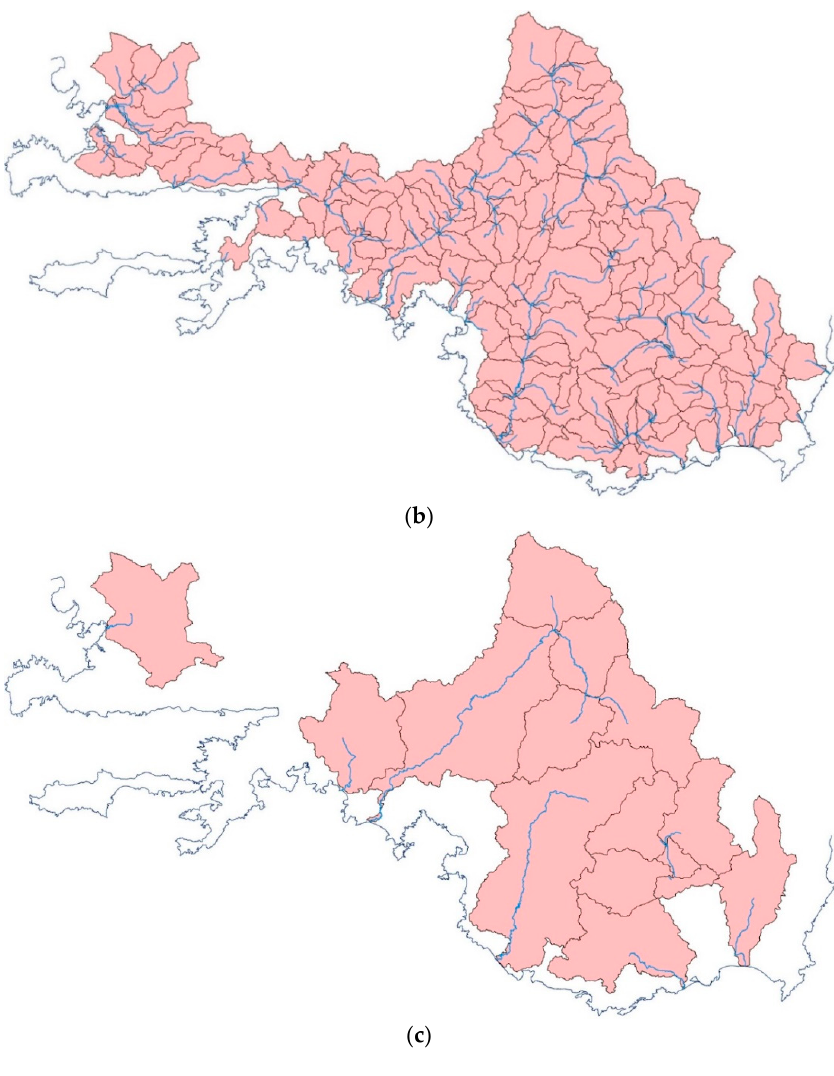
Figure 10. ( a ) The catchments derived from the BeST drainage network. ( b ) The catchments derived from the OnePercent drainage network. ( c ) The catchments derived from the LaST drainage network.